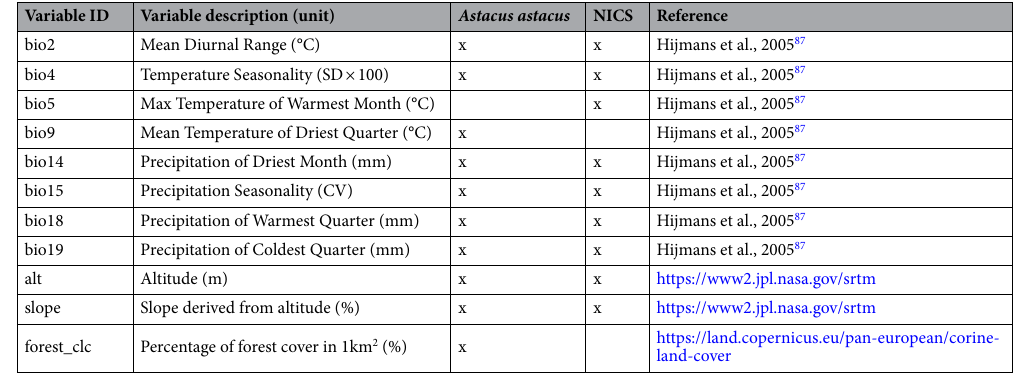
Table 3 . Environmental predictor variables used for building SDMs of indigenous Astacus astacus and the two NICS, Pacifastacus leniusculus and Faxonius limosus . x—used in model